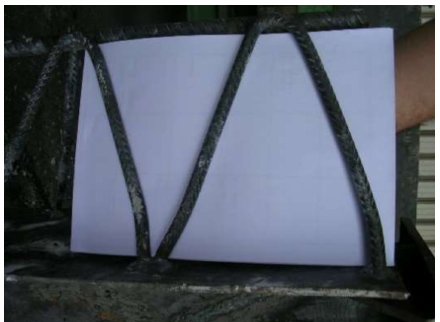
Figure 9. Deformed shape of the steel truss at the end of test B12_2 (Aiello) [5].